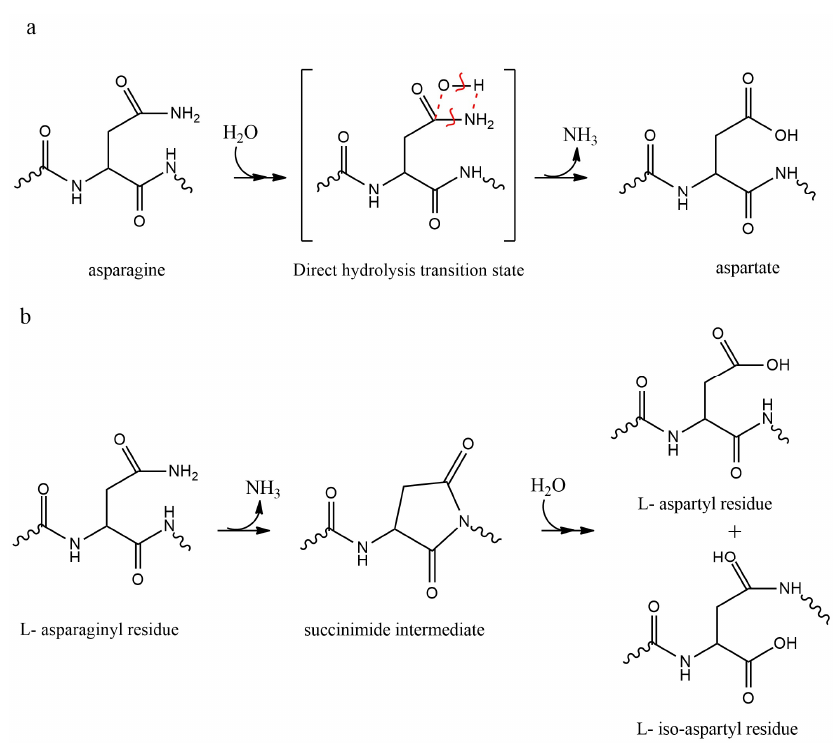
Figure 2. Deamidation pathways of asparagine through ( a ) direct hydrolysis and ( b ) succinimide mediation [85]. Red lines show the proton transfer from water molecule to the leaving group ( ‐ NH 2 ).